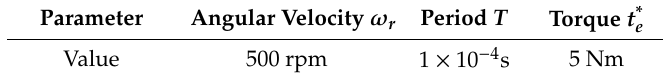
Table 2. Simulation conditions.